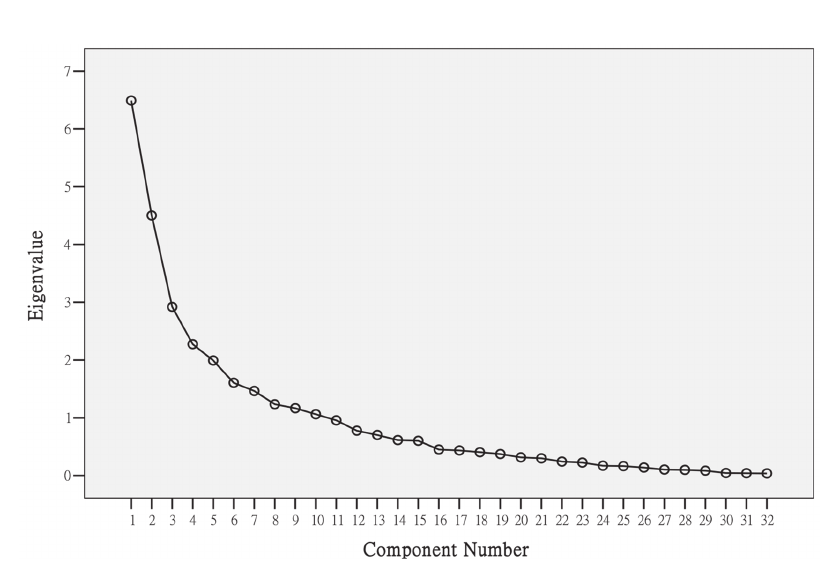
Fig. 1. Scree plot for factor